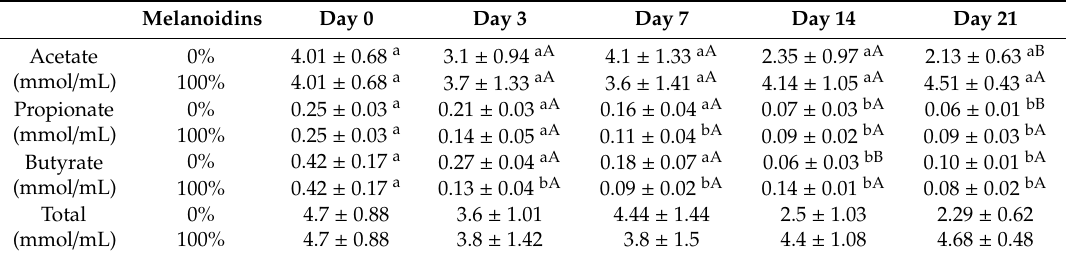
Table 3. E ff ects of melanoidin malts on short-chain fatty acids. Data are expressed as mean ± SEM ( n =